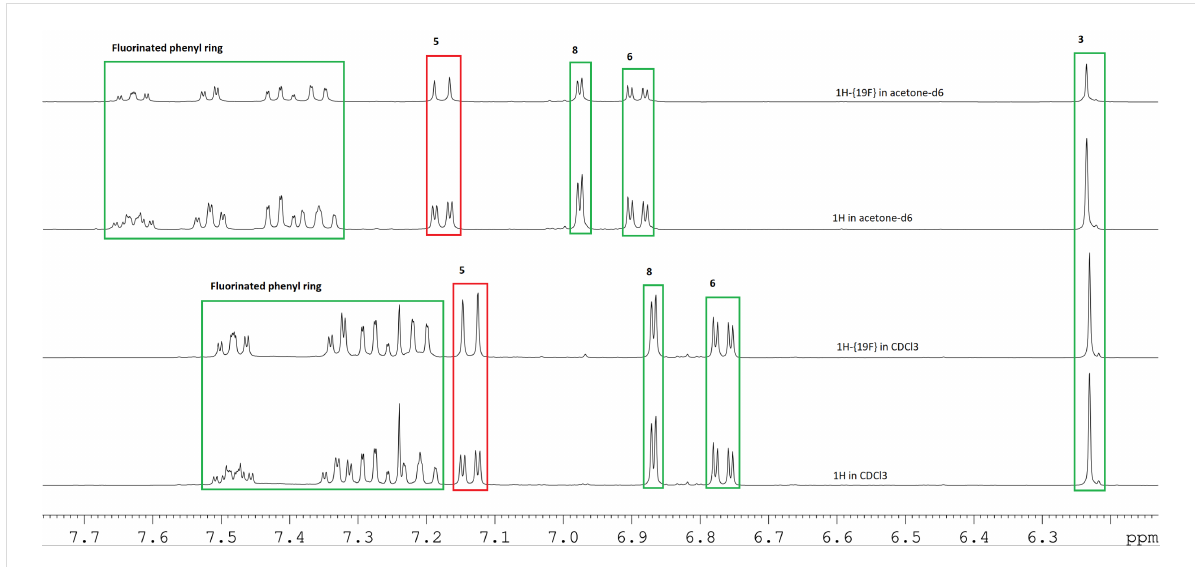
with dimethyl sulfate, to form 4-(2-fluorophenyl)-7-methoxy- coumarin ( 6